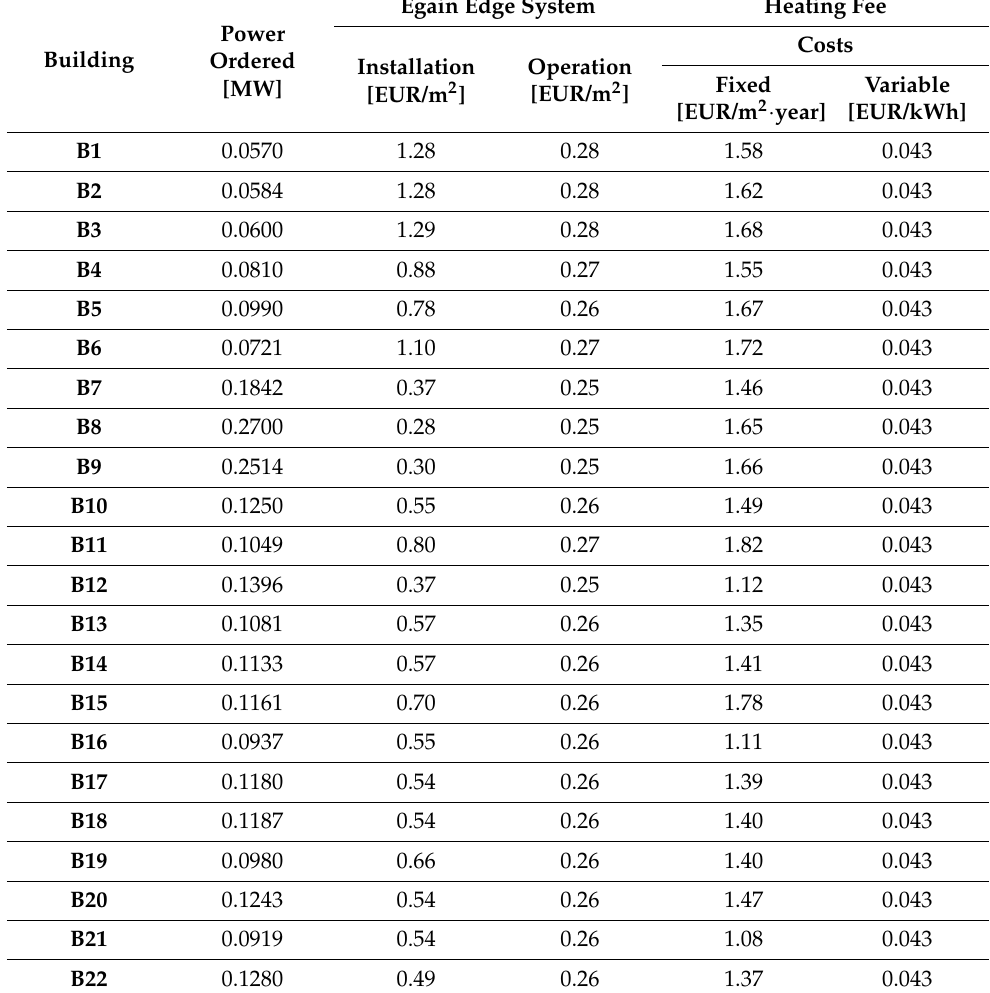
Table 14. A statement of the adopted costs for conducting the economic